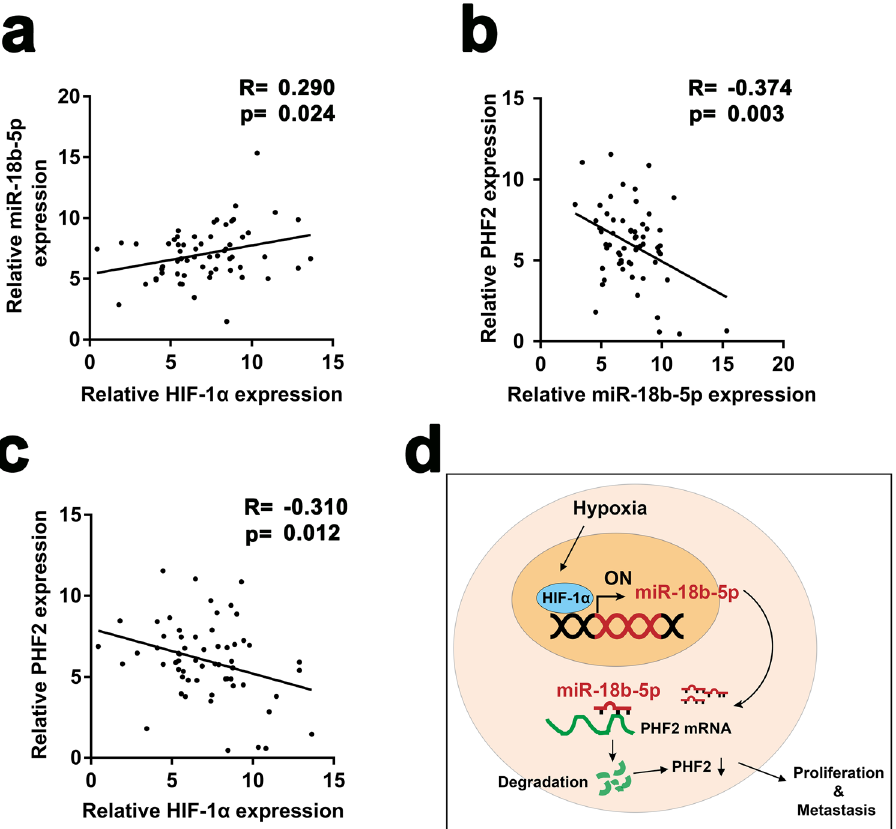
Figure 6. Hypoxia induced miR-18b-5p promotes OS via HIF-1α-miR-18b-5p-PHF2 axis. ( a – c ) Pearson correlation analysis showed the correlation between miR-18b-5p and HIF-1α, miR-18b-5p and PHF2, PHF2 and HIF-1α in OS tissues determined by RT-qPCR. ( d ) Schematic diagram showed the molecular mechanism of miR-18b-5p involved in